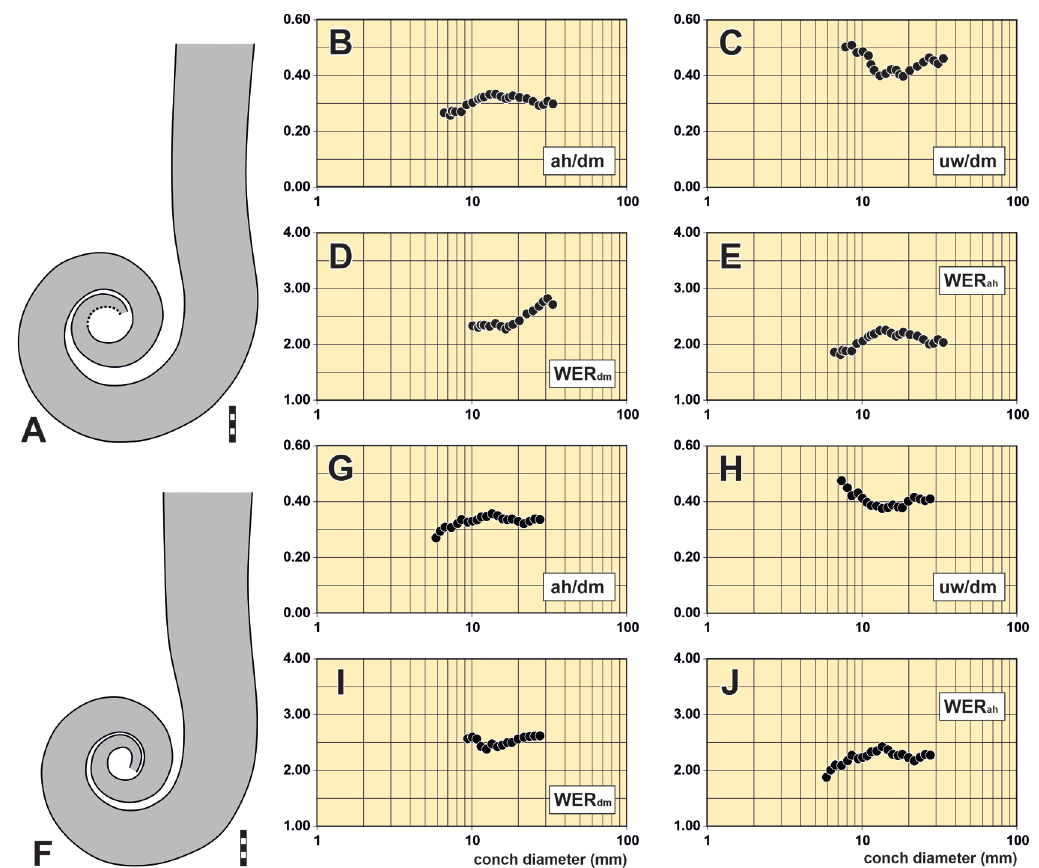
Fig. 64. Lituites kruegeri sp. nov. and Lituites cf. kruegeri . A . L. kruegeri sp. nov., outline of coiled conch part of holotype MB.C.30539. B–E . L. kruegeri sp. nov., conch proportions and coiling rates of holotype MB.C.30539. F . L. cf. kruegeri , outline of coiled conch part of specimen MB.C.30540. G–J . L. cf. kruegeri , conch proportions and coiling rates of specimen MB.C.30540. Scale bar units = 1